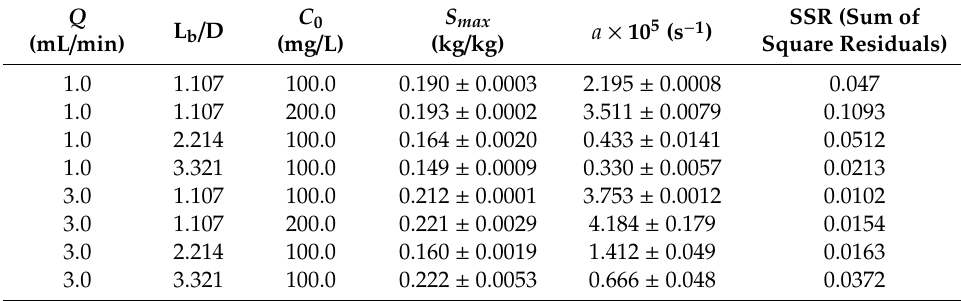
Table 8. Sorption parameters estimated with inverse modeling of column tests ( T = 25 ◦